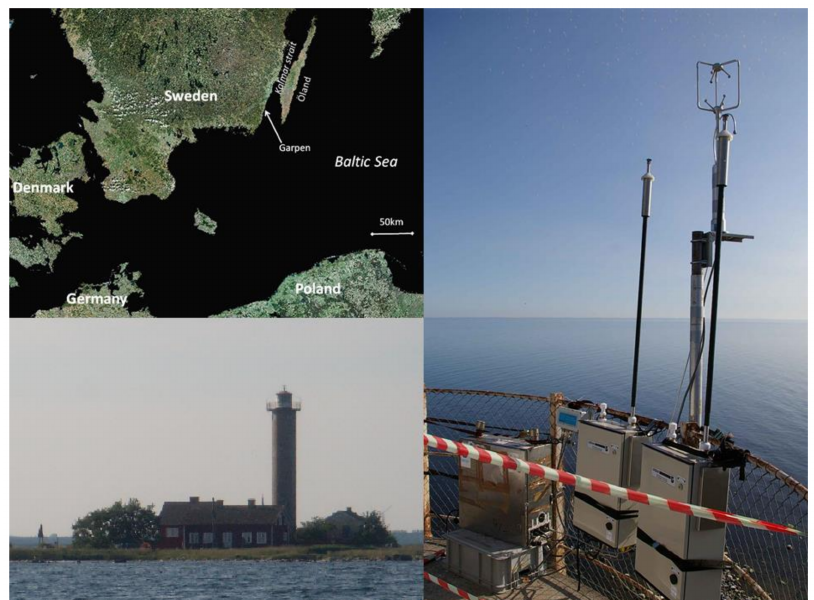
Figure 1. On the upper-left panel, the location of the island of Garpen and lighthouse station in the Kalmar Strait, southern Baltic Sea. Right panel shows the flux system (photo credit: Douglas Nilsson). Lower-left panel is a reshaped photo of the Garpen lighthouse (source: https://www.wikidata.org/ wiki/Q10503160, accessed on 17 February